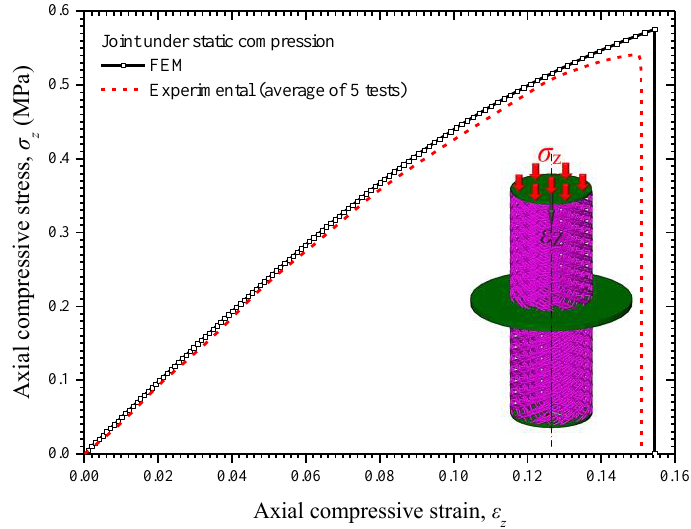
Figure 7. Stress – strain curve of the joint under axial compression. Figure 7. Stress–strain curve of the joint under axial